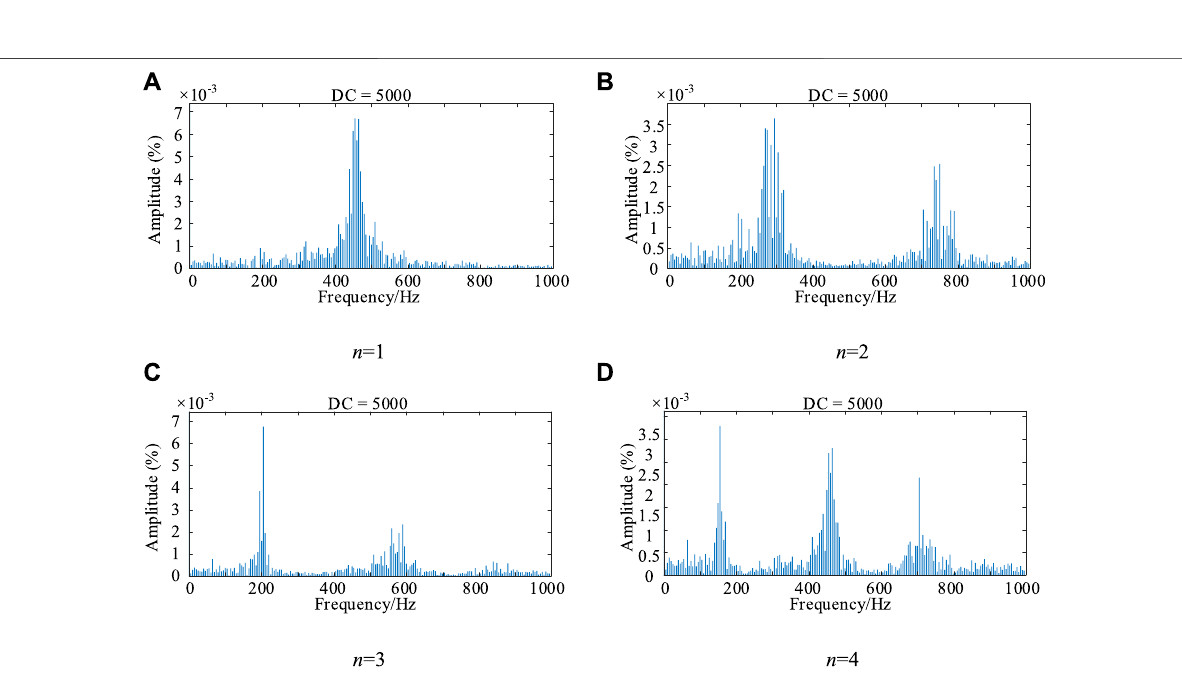
TABLE 2 | Parameters of the converter.